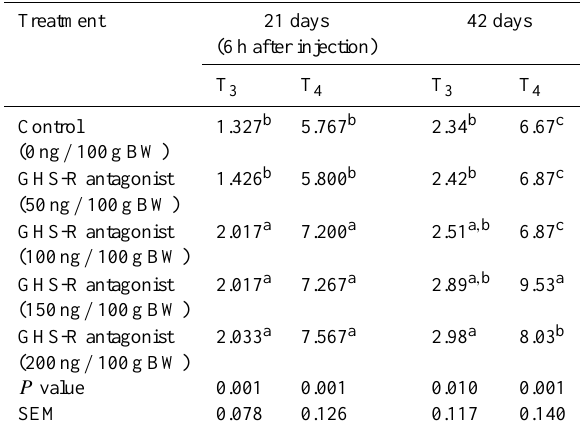
Table 5. Effects of peripheral GHS-R antagonist on thyroid hor- mones in broiler chicks (ngmL − 1